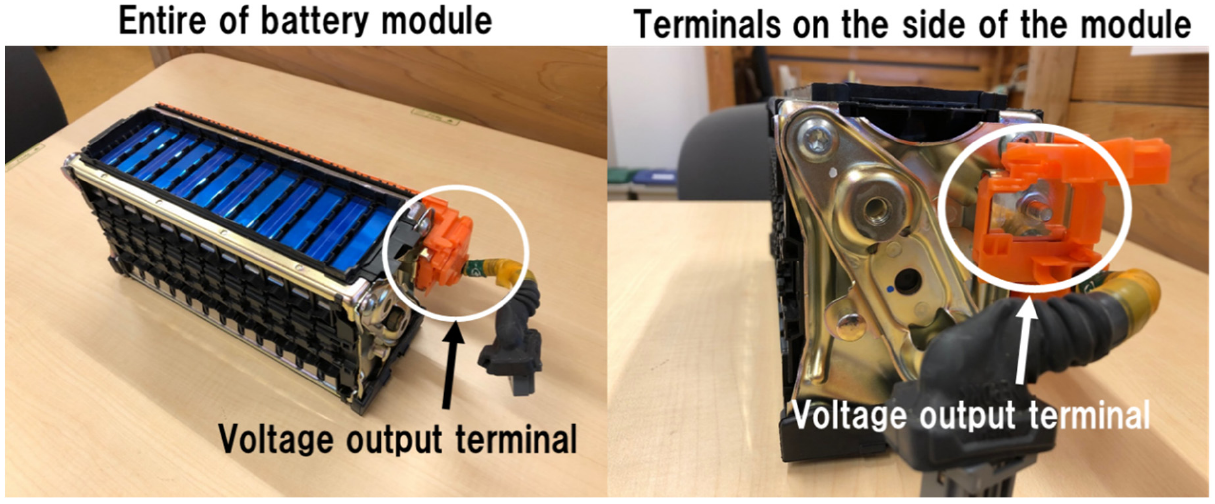
Figure 3. Photograph of the entire battery module from HONDA Fit.